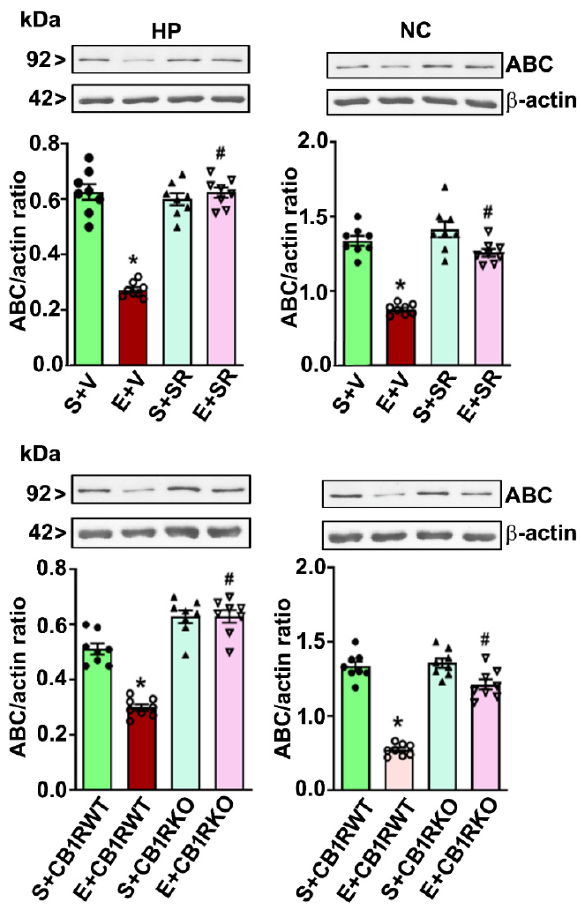
Figure 4. Preadministration of SR or genetic deletion of CB1Rs mitigates high-dose